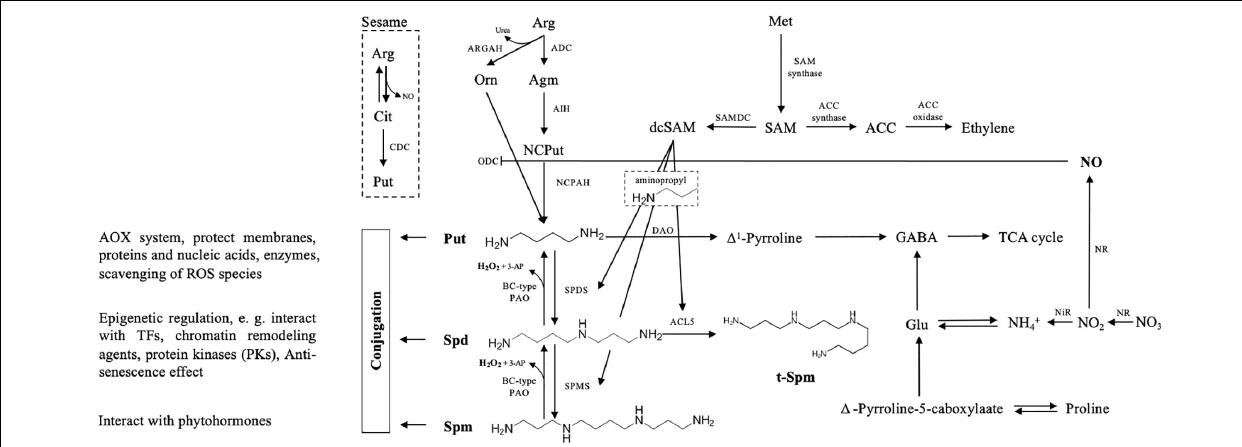
FIGURE 1 | Schematic overview of polyamine (PA) metabolism with interconnection to other metabolic routes. Put biosynthesis may follow three pathways, of which the citrulline (Cit) pathway is reported so far only in sesame plants, where arginine (Arg) is catalyzed by Cit decarboxylase (CDC). The other two main routes include a direct conversion from ornithine (Orn) to Put by the action of ODC, and another indirect pathway with three steps, where ADC, AIH, and NCPAH sequentially decompose Arg, agmatine (Agm), and N -carbmoyl-Put, to finally generate Put. In both spermidine (Spd) and spermine (Spm) synthesize pathways, the aminopropyl moieties derived from dcSAM are required, which derived from SAM and catalyzed by the SAMDC enzyme. PA oxidases (PAOs, exhibiting apoplastic activity) catalyze an oxidation-back-reversion reaction (BC-type reaction) to generate H 2 O 2 that allows “Spm to Spd and to Put” retroconversion. Another catabolite of Put is (cid:49) 1 -Pyrroline triggered by diamine oxidase (DAO). In this pathway, γ -aminobutyric acid (GABA), NO, and proline (Pro) are generated, and NO inhibits ODC activity. Regarding cellular PA-homeostasis, besides free soluble and non-covalently conjugated forms, PAs may also bind to proteins and other molecules to protect the macromolecules, regulate transporter/channel activity and gene expression, or interact with some hormones. This metabolism presentation of PAs in the plant is partially adapted from the studies by Gonzalez et al. (2021) and Spormann et al.